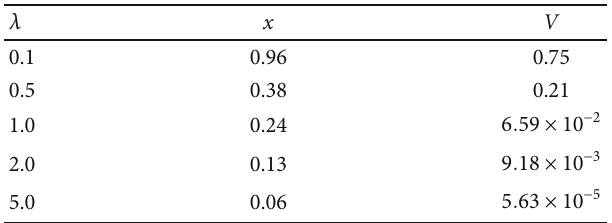
and x for di ff erent values of λ tot